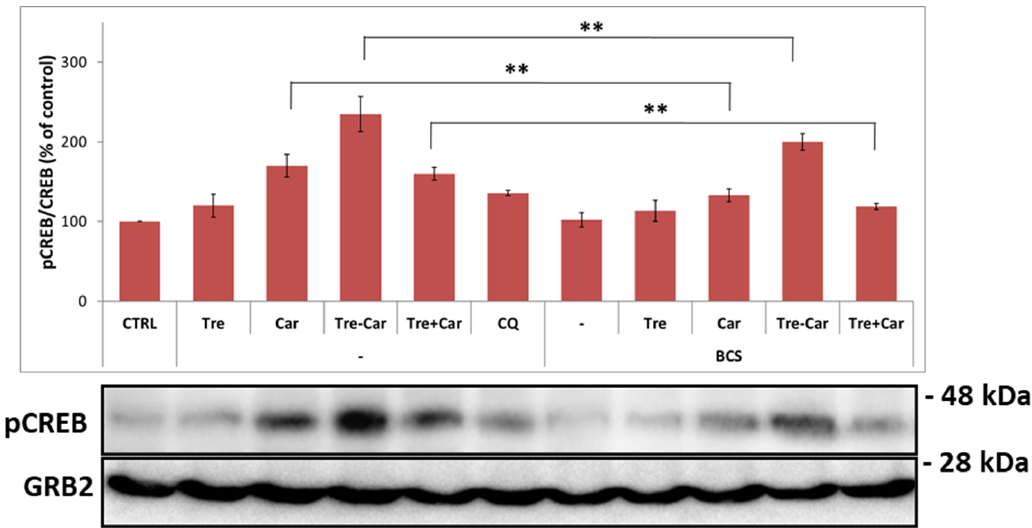
Figure 5. Effect of the extracellular chelator BCS on CREB phosphorylation induced by Tre, Car, Tre-Car and Tre + Car mixture. Representative western blotting and densitometric analyses of pCREB in PC12 cells treated with 5 mM of studied compounds or 10 µ M CQ for 30 min in RPMI-1640 complete medium, without FBS or in the presence of 50 µ M BCS 24 h pre-treated medium. The phosphorylated level of CREB was reported as ratio over the GRB2 protein (** p ≤ 0.01 versus the respective control/treatment). Dashes to the right of the membrane bands show positions of prestained molecular mass marker.